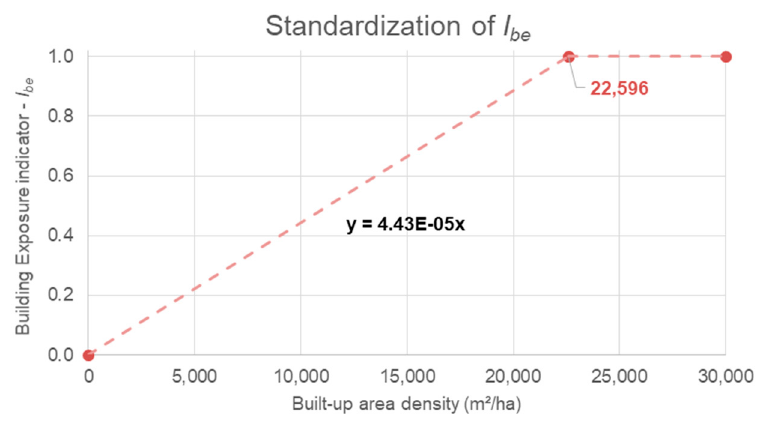
Figure 1. Standardization of the Building Exposure indicator (I be ).